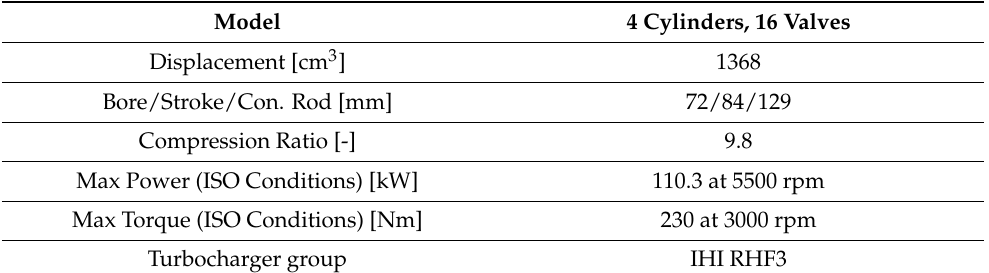
Table 2. Engine main characteristics.